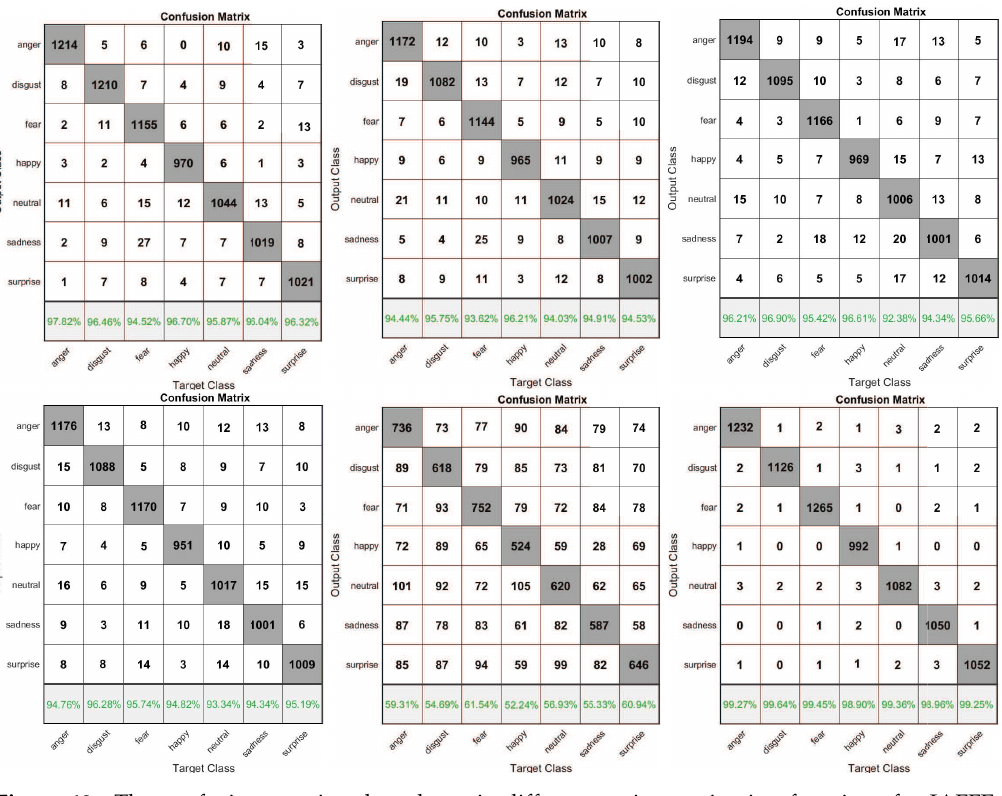
Figure 12. The confusion matrixes based on six different variant activation functions for JAFFE database. From left to right, the corresponding activation functions are: sigmoid, tanh, ReLu, leaky ReLus, softplus–ReLu and the new activation function (LS–ReLu). Table 3. This table summarises the average accuracy rates produced by different common activation functions and the new activation function in facial expression recognition on JAFFE